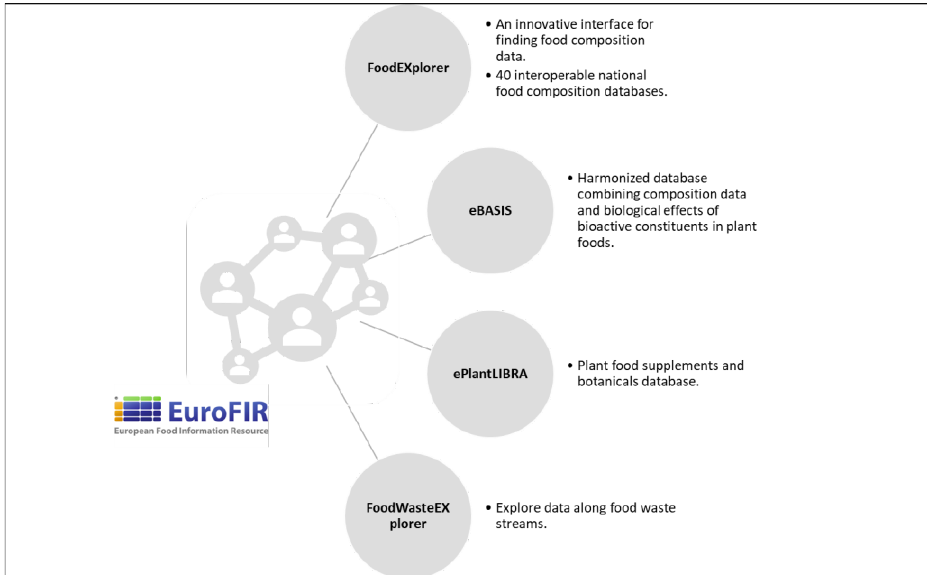
Figure 2. Representation of main EuroFIR AISBL tools.